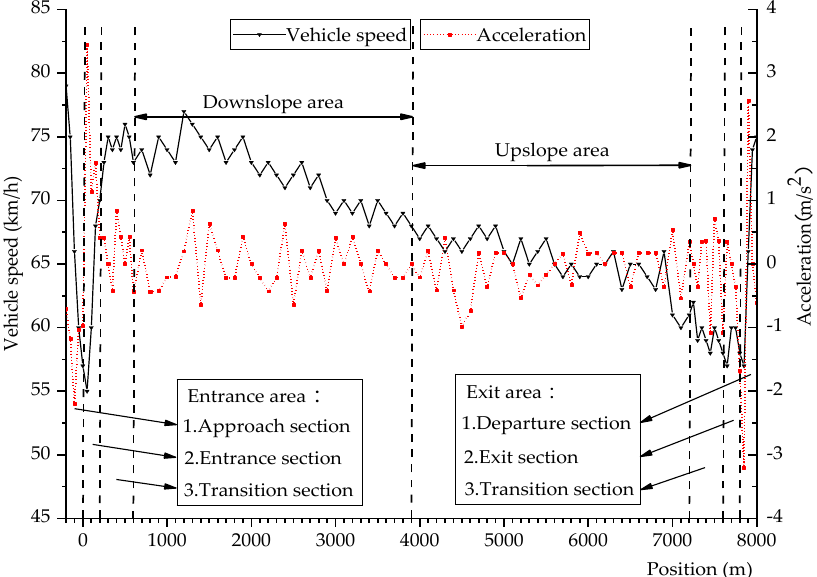
Figure 4. Distribution of the vehicle speed and acceleration.